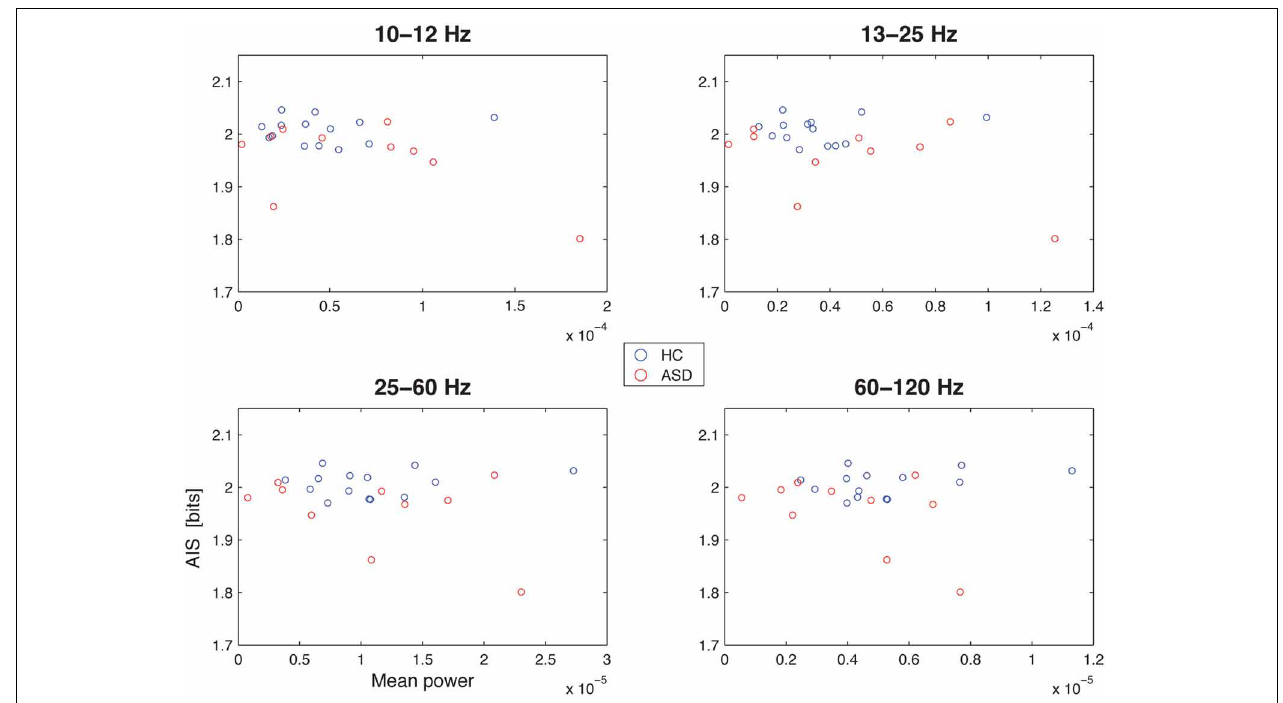
FIGURE 3 | Correlation between spectral power and AIS in the hippocampal source. Correlation between spectral power in the 10–12Hz α -, the 13–15Hz β -, the 25–60Hz low frequency γ -, and